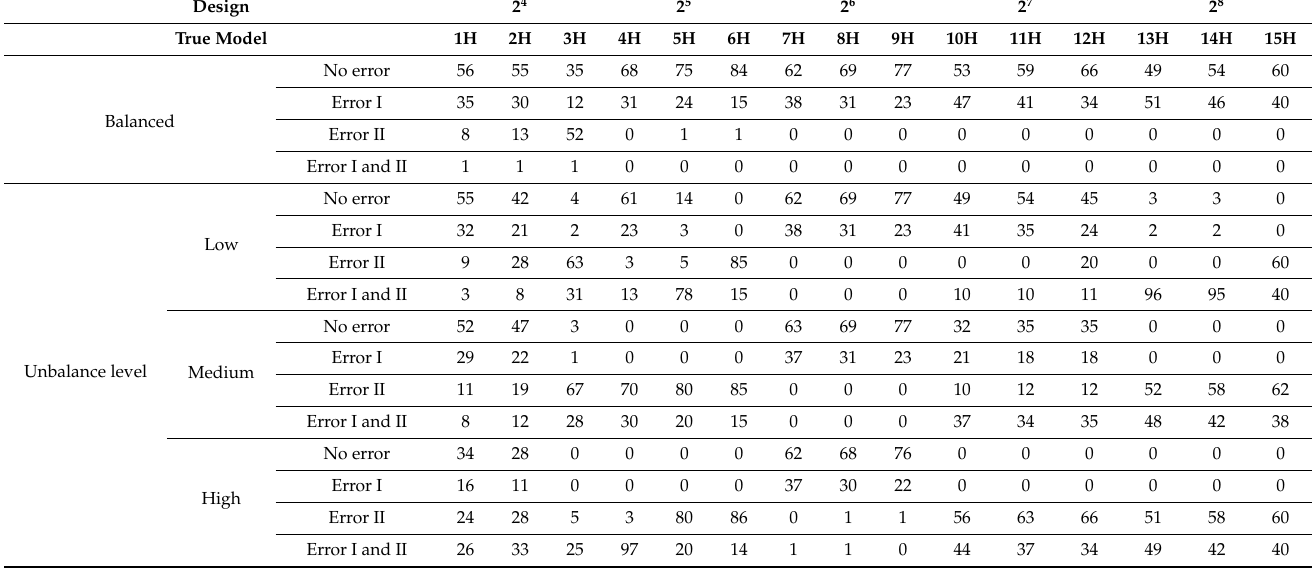
Table 9. % Error behavior with high noise.